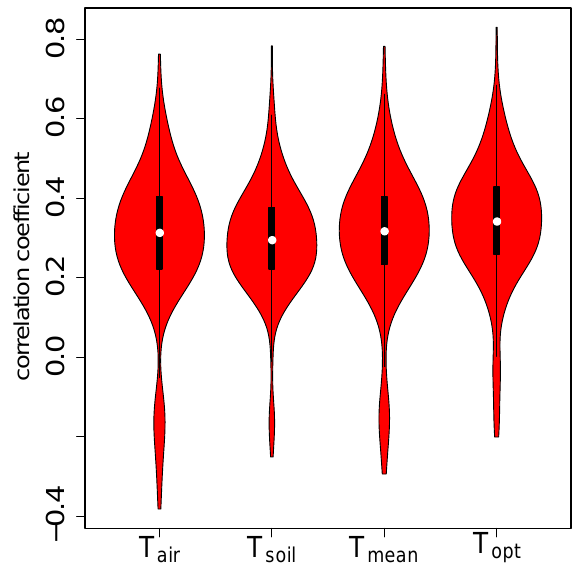
Fig. 3. Correlation with nighttime NEE with T air , T soil , the average of the two, T mean and an weighted average with optimised weights, T opt , is computed for 12days time windows. The violin plot shows the distributions of the median of significant correlations for the growing season of each year across FLUXNET sites, the extent in x-direction indicates the frequency of the y-axis value. The point indicates the median, the thick black line is the interquartile range. The median values are (from left to right) 0.315, 0.297,0.319 and